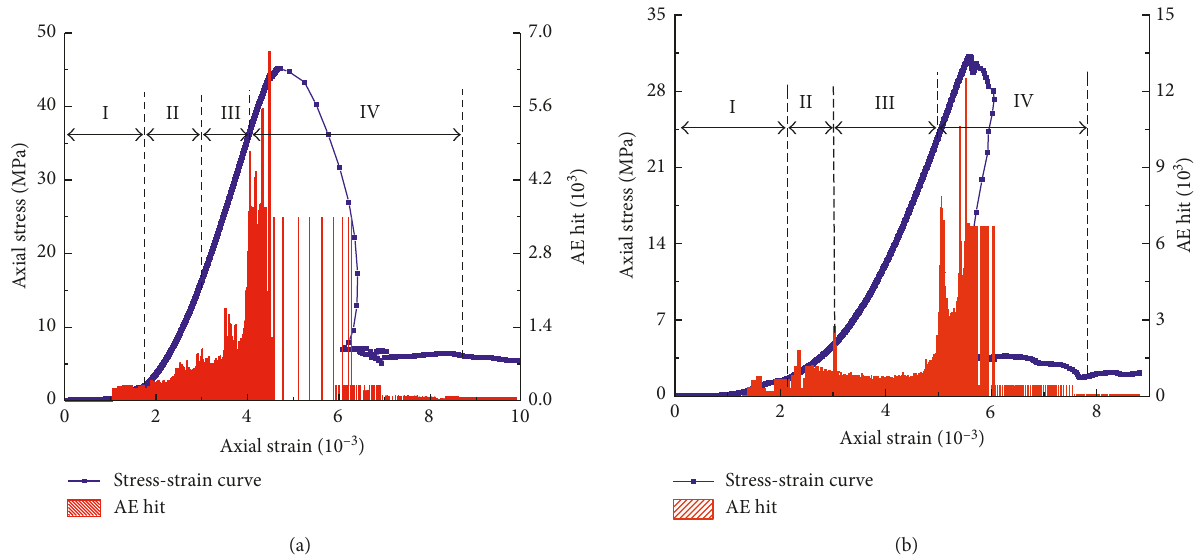
Figure 4: Relationship between axial stress-strain and AE counts of sandstone specimen containing fissure angle α deformation. (a) Without seepage pressure. (b) With seepage